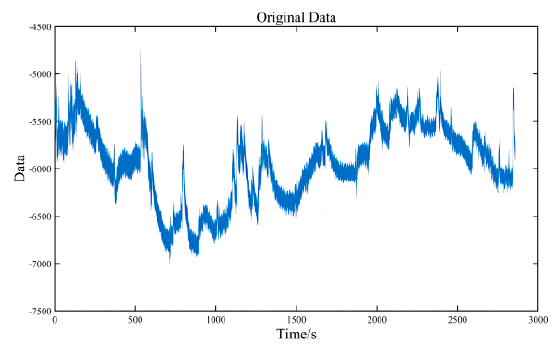
Figure 5. Raw data of CBz of the subjcet03.